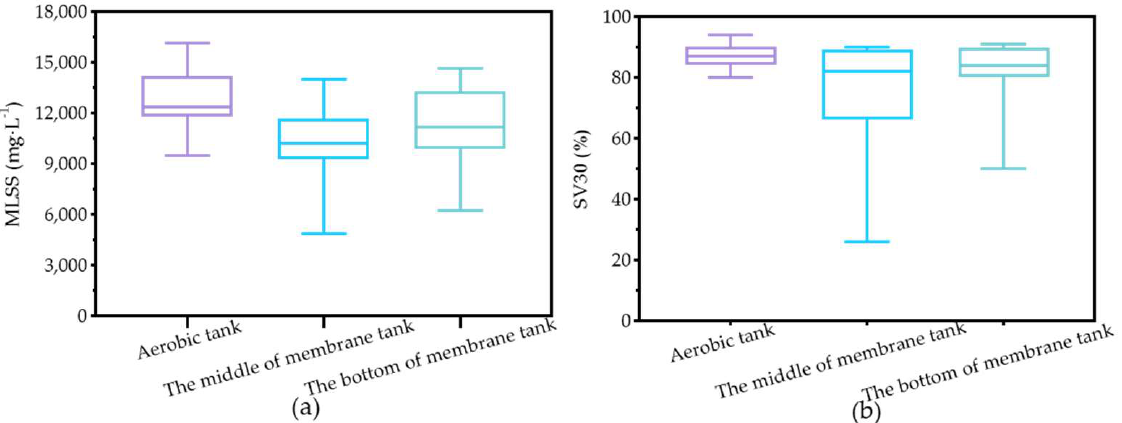
Figure 5. The MLSS ( a ) and SV 30 ( b ) in the aeration tank and the middle and bottom of the membrane in the LEP-N-MBR system.